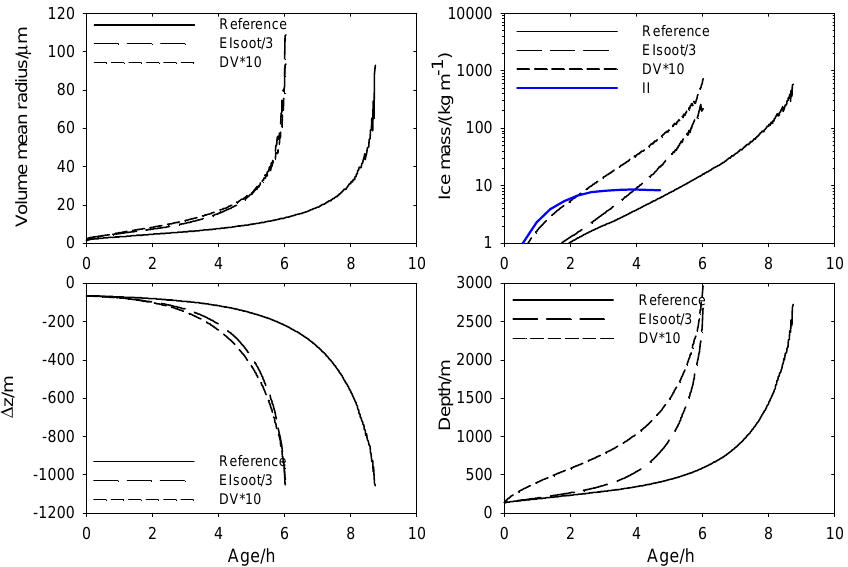
Fig. 15. Same as Fig. 14 for further contrail properties. Top-left panel: Volume mean radius r . Top-right: black: Ice mass per contrail length, blue: 2d model result II. Bottom-left: Vertical sedimentation displacement 1z . Bottom-right: Contrail depth D .